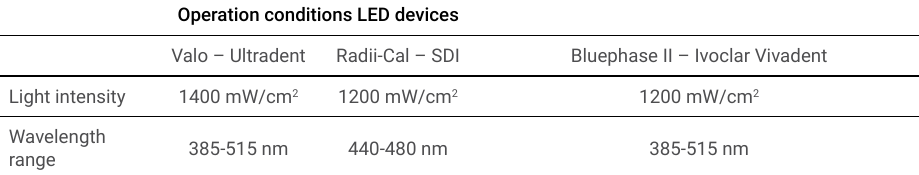
Table 2. Description of light-curing units (LCU) used in this study, considering their respective light parameters (power intensity and wavelength) Operation conditions LED